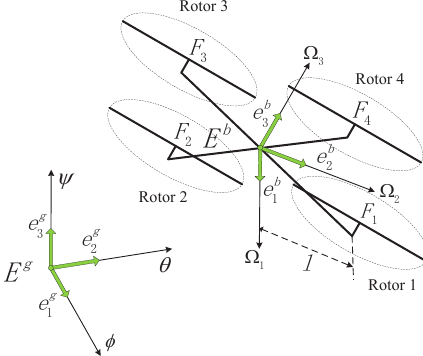
Figure 2. Quadrotor UAV